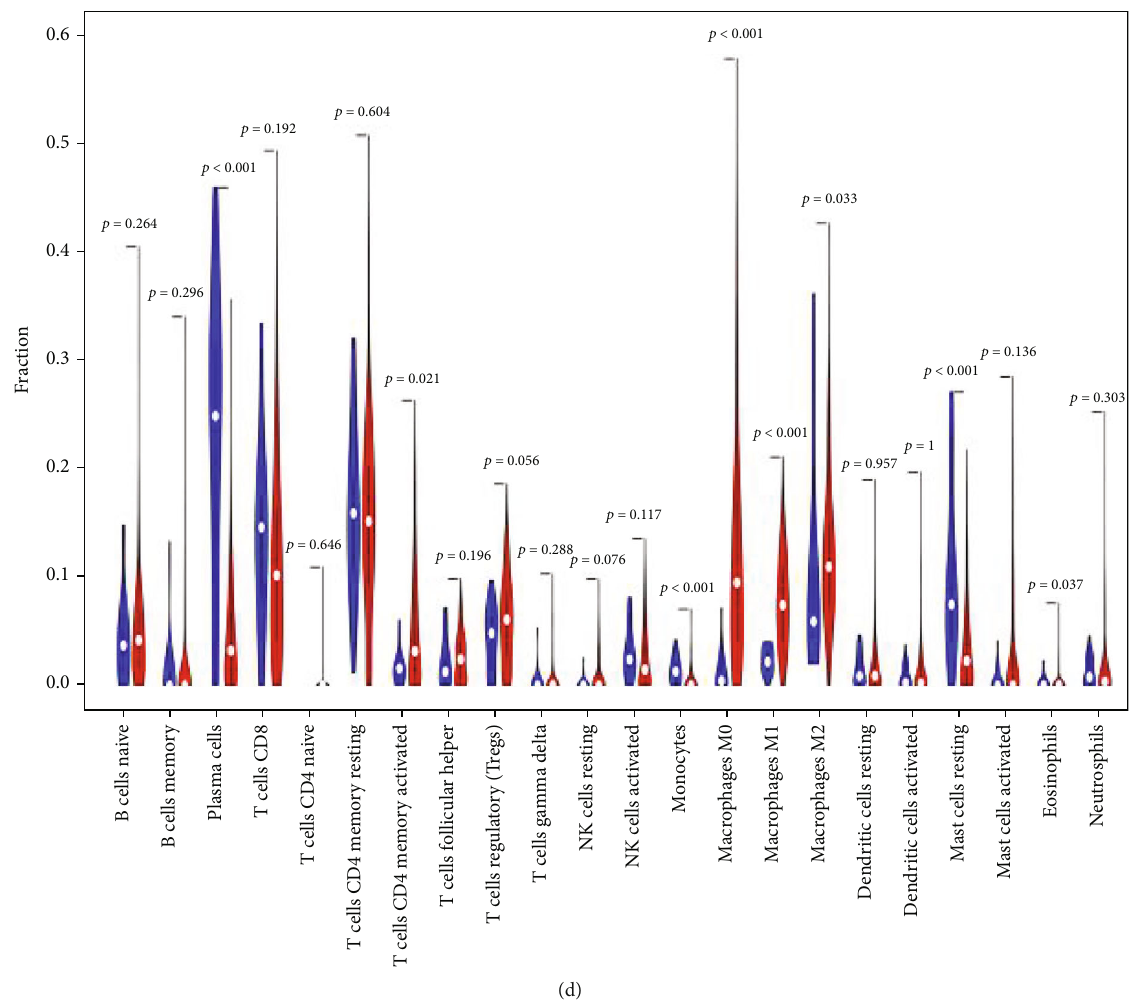
Figure 1: Analysis of immune cell in fi ltration. (a) Histogram of immune cell distribution in GC. (b) Heatmap of immune cell distribution in GC. (c) Heatmap of immune cell interaction in GC. (d) Violin plot of the relative content of immune cells in